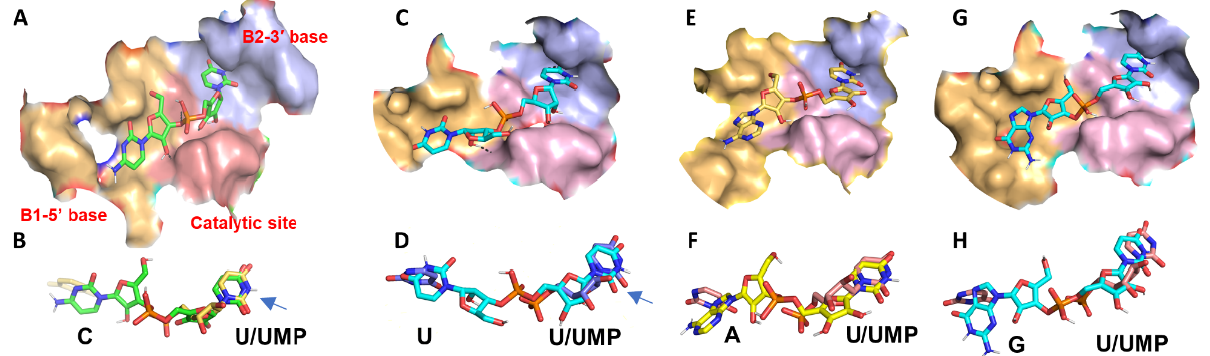
Figure 3. Interactions of RNase MC1 with different dinucleotides. ( A ) Surface view of RNase MC1 docked with CpU dinucleotide. ( B ) Overlay of docked CpU (green) and the bound 5 ′ -UMP in crystal structure, 1UCD (yellow). ( C ) Surface view of RNase MC1 docked with UpU. ( D ) Overlay of docked UpU (cyan) and 5 ′ -UMP of 1UCD (yellow). ( E ) Surface view of RNase MC1 docked with ApU. ( F ) overlay of the docked ApU (light yellow) and 5 ′ -UMP of 1UCD (orange) ( G ) surface view of RNase MC1 docked with GpU, ( H ) Overlay of docked GpU (cyan) and 5 ′ -UMP of 1UCD (orange). The surface view with base recognition and catalytic sites (depicted in different colors) was exported following the ligand docking to MC1 by docking software GOLD.